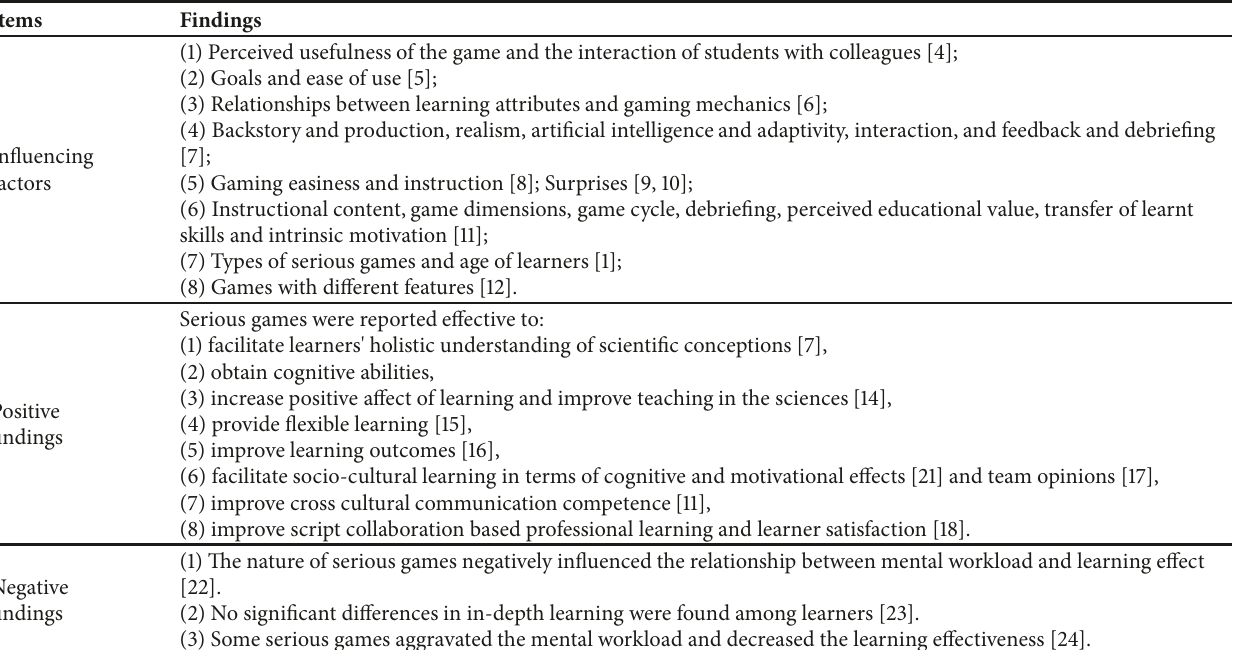
Table 1: A summary of influencing factors, positive and negative